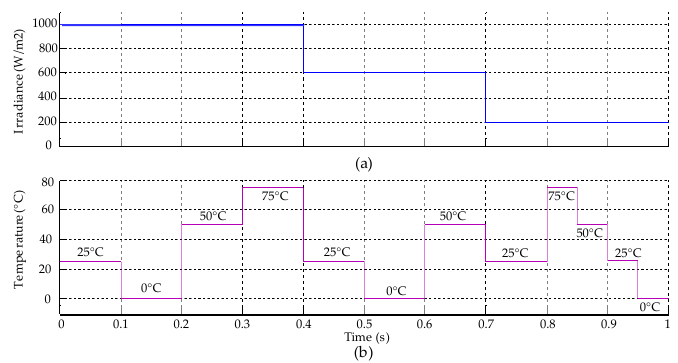
Figure 21. Irradiance and temperature signals to evaluate the performance of fuzzy and P&O controllers. ( a ) Increases in solar irradiance; ( b ) Variable temperature.